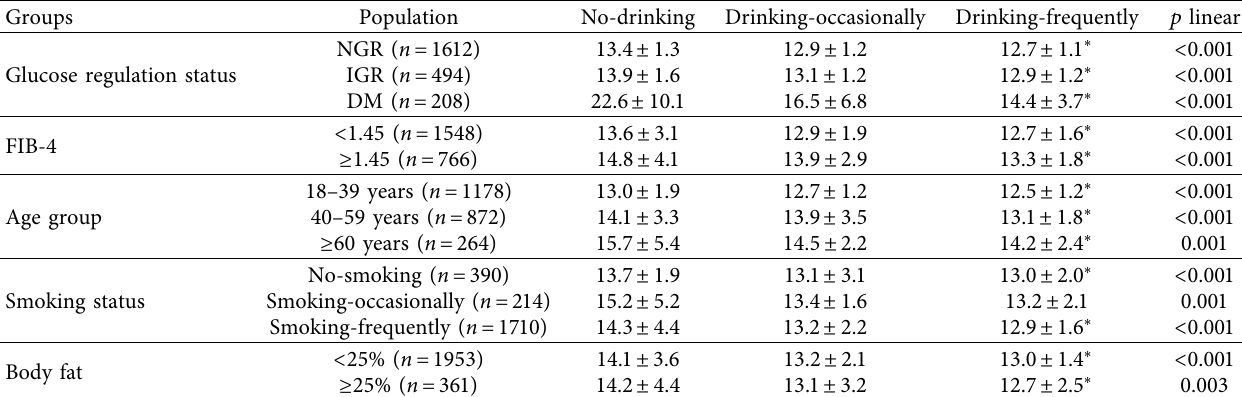
Table 2: Effects of drinking status on glycated albumin levels (%, mean ±